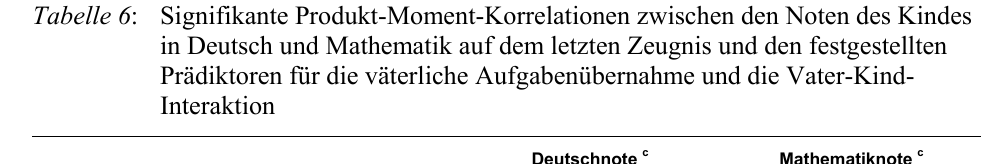
Tabelle 6 : Signifikante Produkt-Moment-Korrelationen zwischen den Noten des